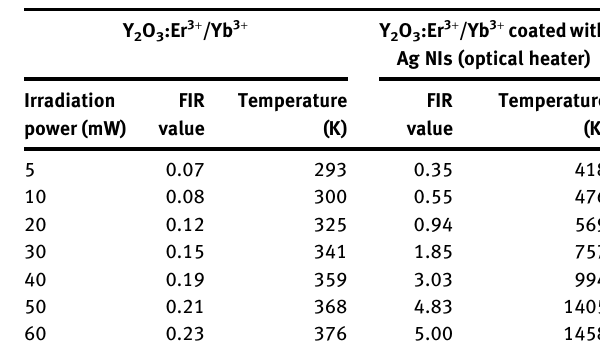
Table  : Temperatures obtained from FIR measurement at different excitation powers.